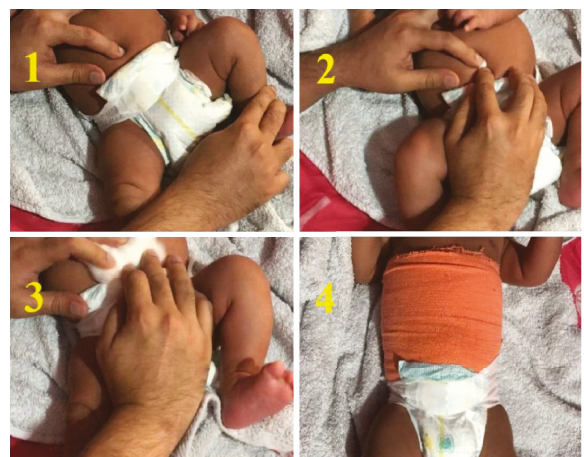
Figure 2: Stepwise technique in the management of infantile umbilical hernia.